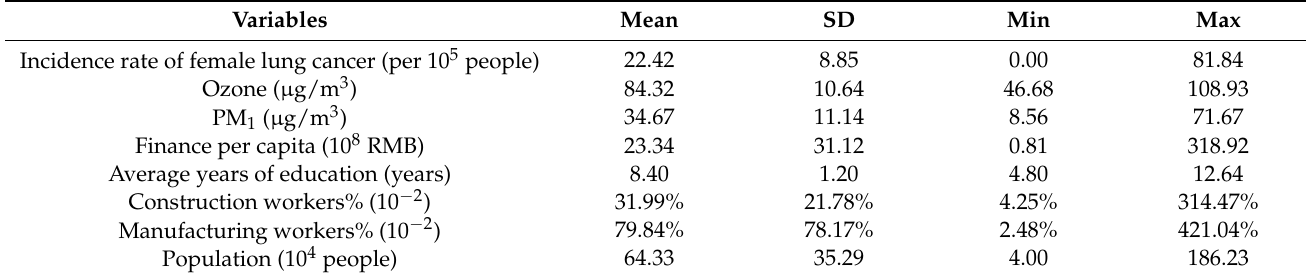
Table 1. Descriptive analysis of health outcome, air pollutants and socioeconomic covariates for 436 counties (districts). Variables Mean SD Incidence rate of female lung cancer (per 10 5 people)